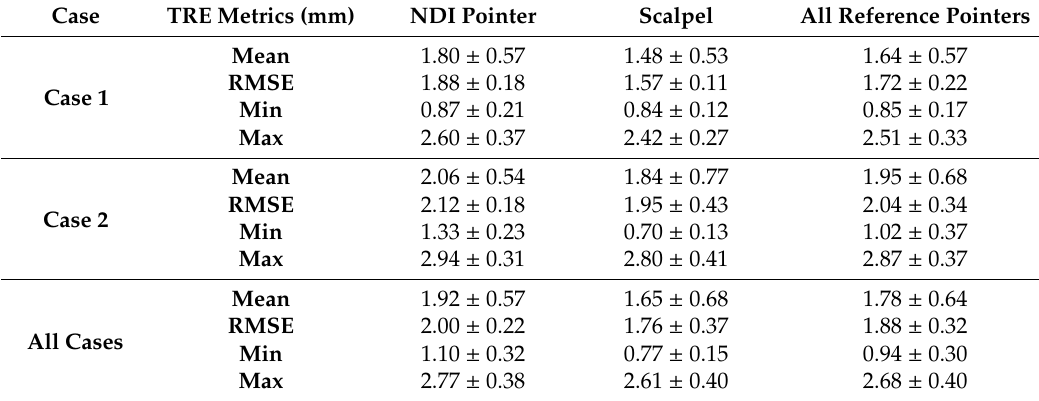
Table 1. Target Registration Error (TRE) (mm) obtained using each reference pointer (NDI pointer and scalpel) for cases 1 and 2 as well as the combined results for both cases and reference pointers. (RMSE: root-mean-square error).